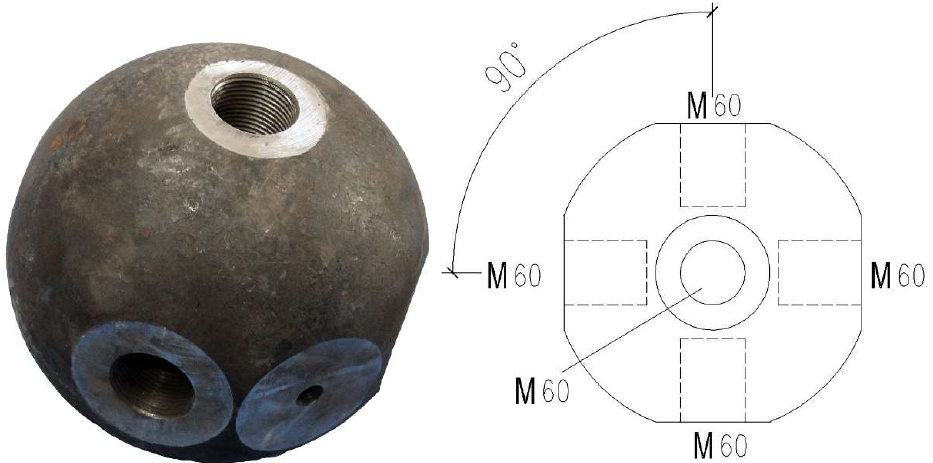
Figure 3. The image and specifications of the prepared bolt sphere.